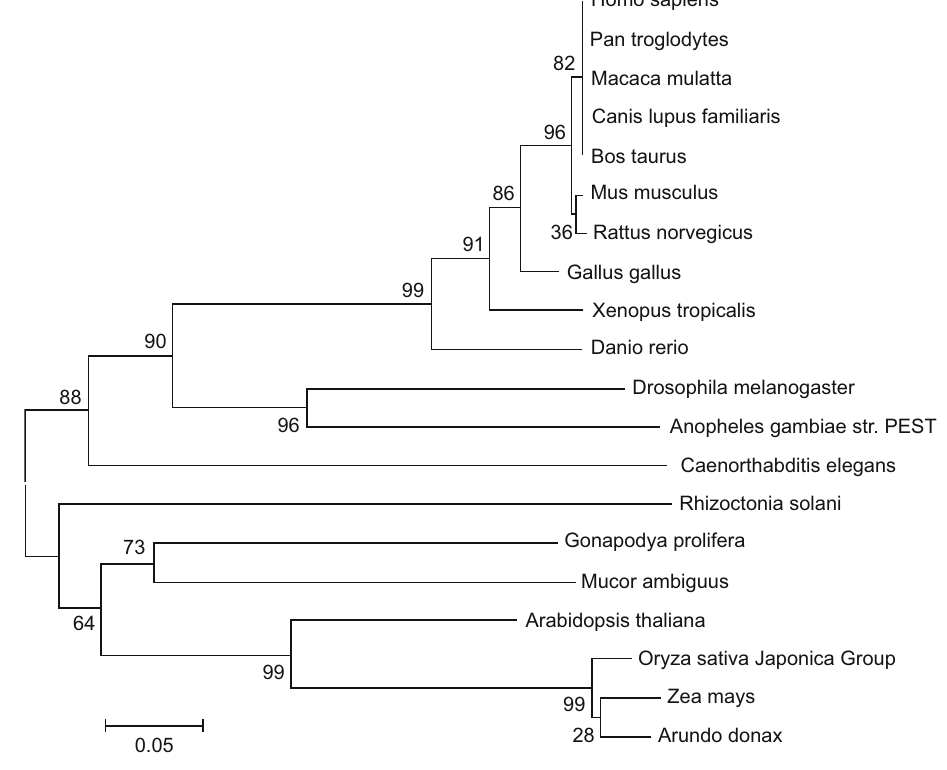
Figure 3. The phylogenetic tree of DDX41 among different species. The sequences of indicated DDX41 proteins from different species are downloaded from GenBank. The tree is generated using MEGA5 software (http://www.megasoftware.net/) with Neighbor Joining method. Length of branch represents divergence and numbers on branches are indicated as percentage of bootstrap values in 1000 sampling